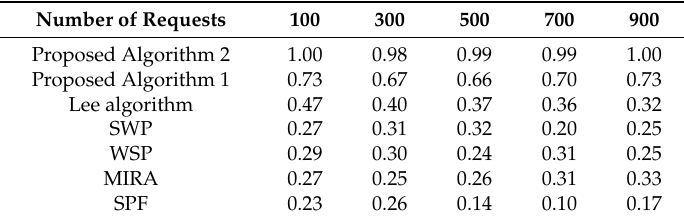
Table 5. The average value of the comprehensive evaluation path when the scheme weight W (cid:48) = [ 0.2,0.3,0.5 ] .